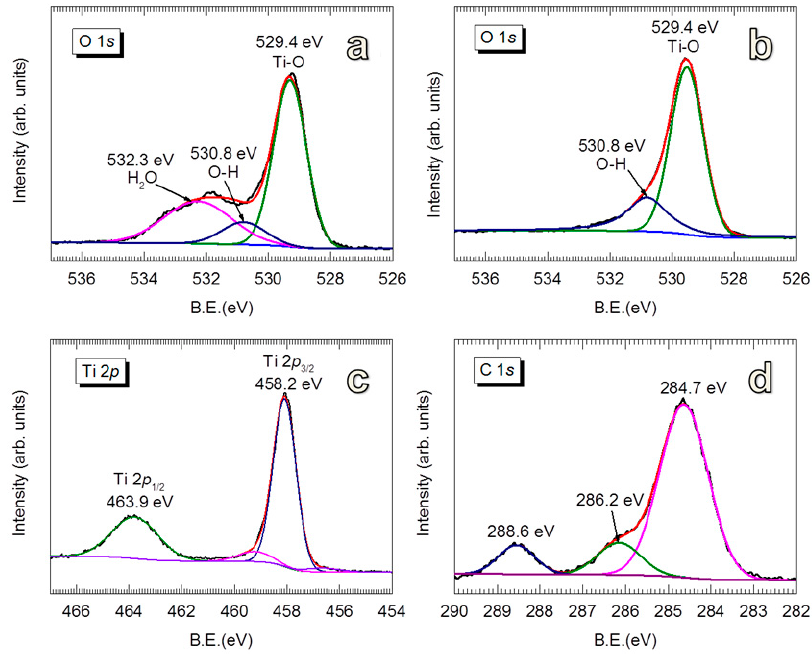
Figure 2. XPS spectra of uncoated anatase TiO 2 powders: O 1 s ( a ) without and ( b ) with preheating (at 170 ◦ C in air), ( c ) Ti 2 p and ( d ) C 1 s